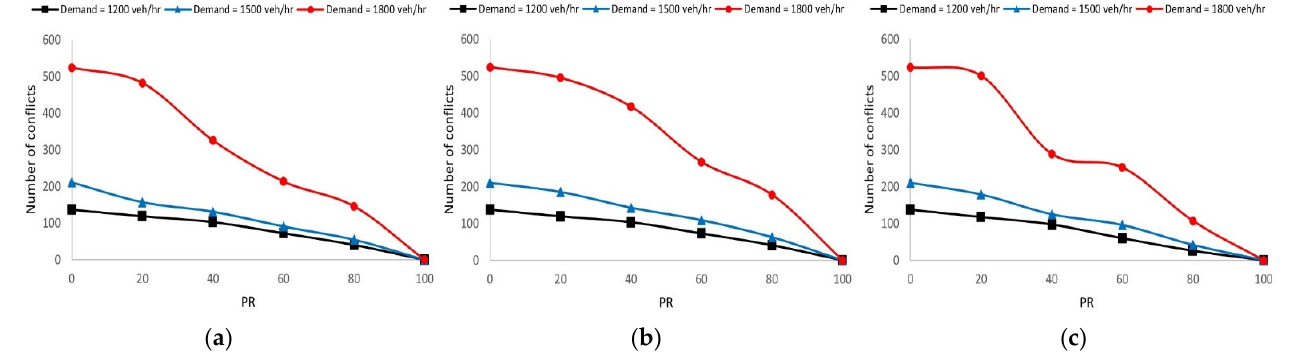
Figure 7. Number of conflicts based on different car-following models: ( a ) Krauss car-following model; ( b ) IDM car-following ( c ); CACC car-following model.